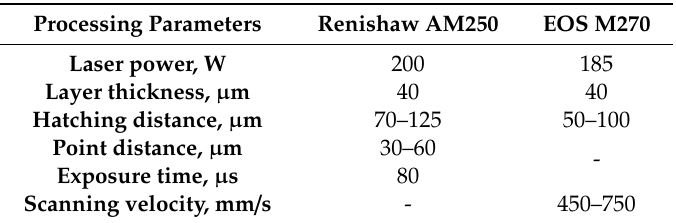
Table 2. Range of L-PBF processing parameters